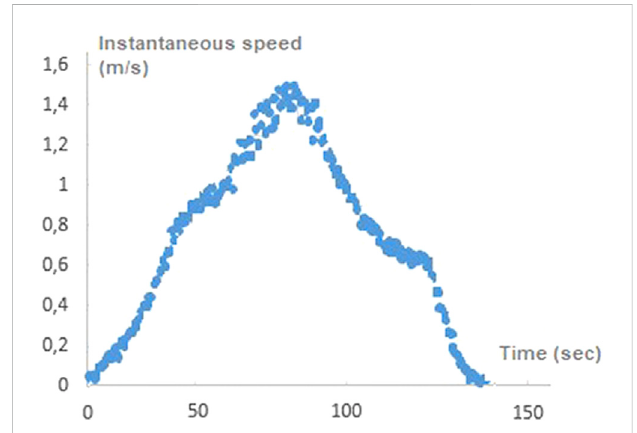
FIGURE 3 Hand motion instantaneous speed across time for a lifting task (1 m distance, no extra